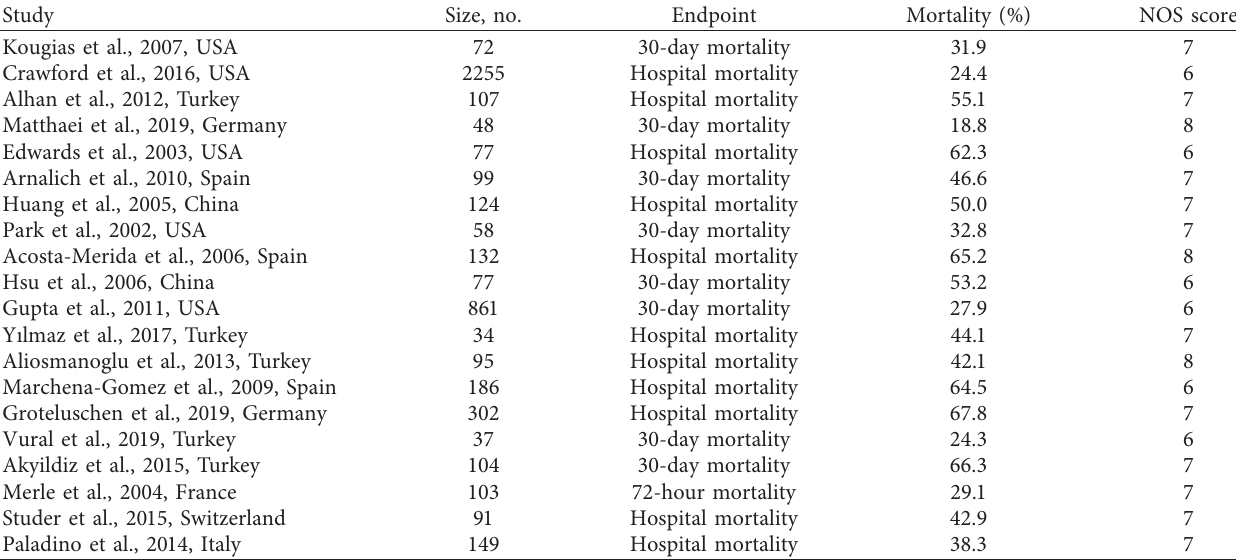
Table 1: Characteristics of